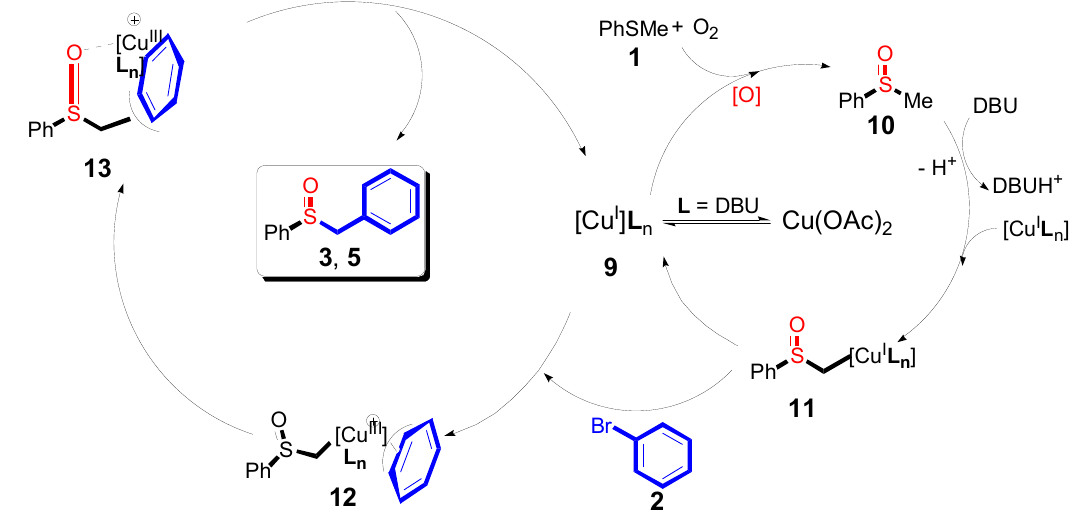
Scheme 5. A possible mechanism for copper-catalyzed direct sulfoxidation.